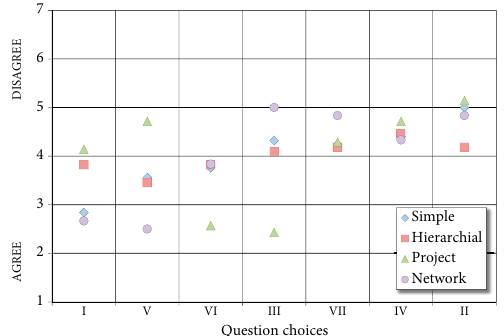
Fig. 6. The perceived function of marketing department according to organizational structure